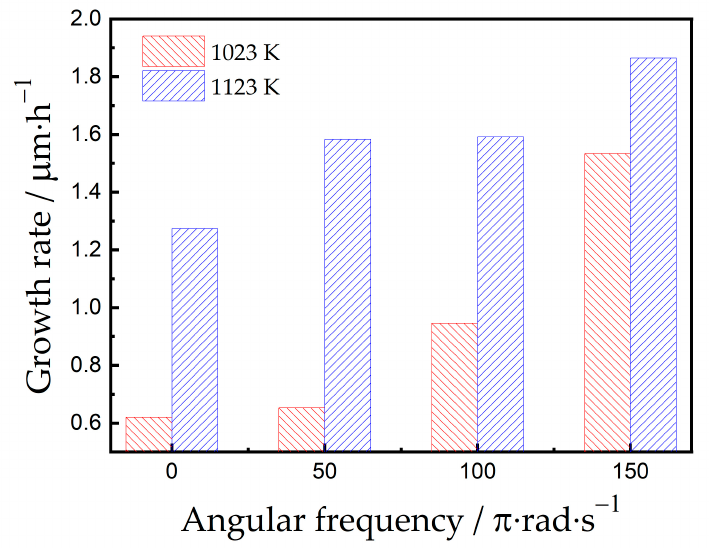
Figure 2. Growth rates of CVD diamond films under a dynamic magnetic field with different angu- lar frequencies.